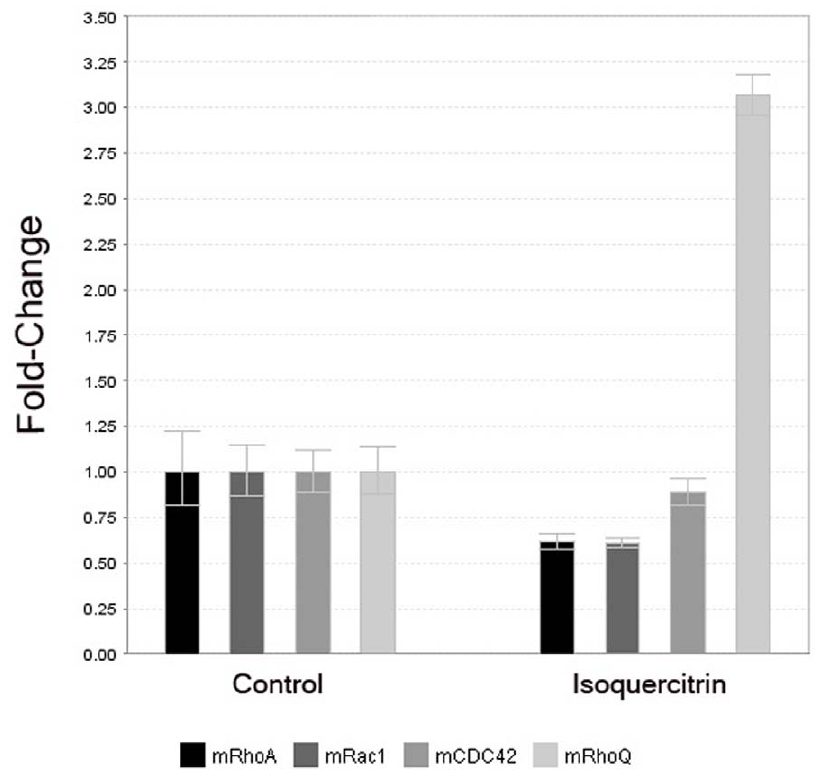
Figure 8. Rho GTPase gene expression is modulated upon 24 hour isoquercitrin stimulation. rhoA gene expression is down-regulated, while expression of rhoQ (TC10) is upregulated in the isoquercitrin treated cells in comparison with the control.